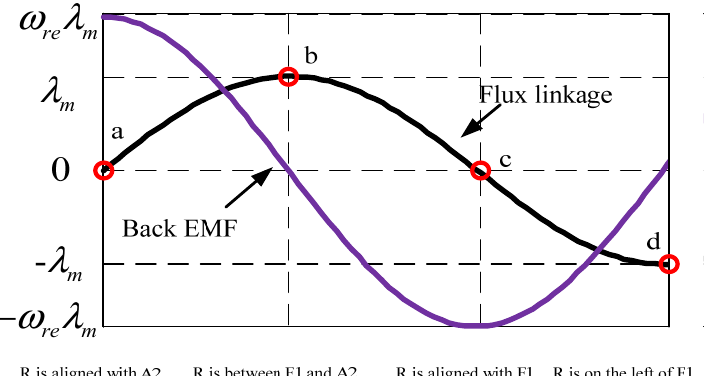
Figure 2. Rotor flux at different rotor positions. ( a ) R is aligned with the A2 axis; (b ) R is between the F1 and A2 axes; ( c ) R is aligned with the F1 axis; ( d ) R is on the left of the F1 axis.